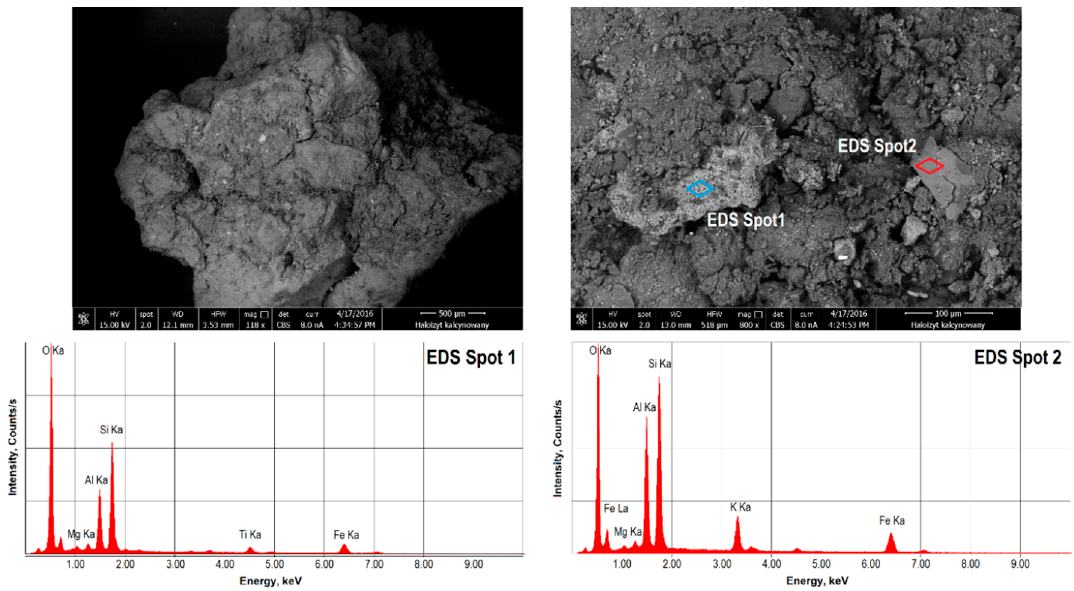
Figure 3. SEM image of the microstructure of the surface of calcined halloysite C-HAL and chemical composition determined by an X-ray dispersion energy spectrometer (EDS).